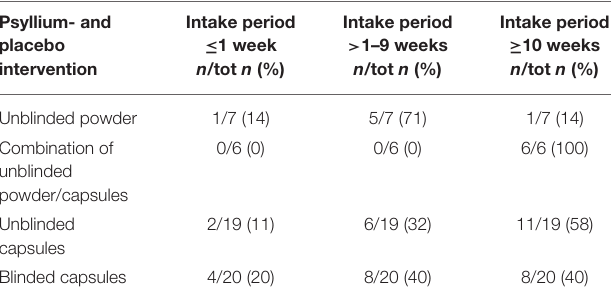
The percentages were rounded to the nearest integer. The Kruskal-Wallis test showed a statistically significant difference in the lengths of the intake periods between the psyllium- and placebo interventions (p = 0.026). The post-hoc test suggested that patients’ intake of the combination of unblinded powder and capsules was longer than the intake of the unblinded powder (p = 0.057; adjusted for multiple comparisons). The adjusted results for the remaining interventions were unblinded